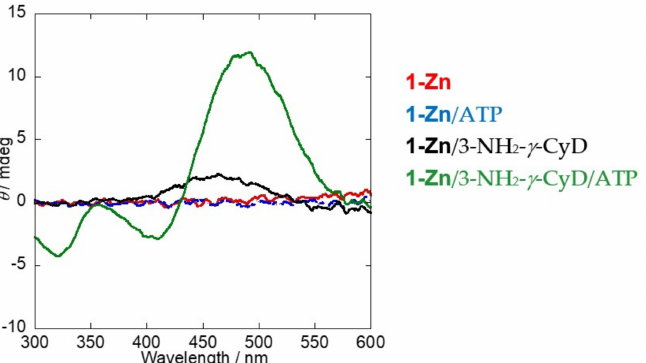
Figure 5. ICD spectra of 1-Zn , 1-Zn /ATP, 1-Zn /3-NH 2 - γ -CyD, and 1-Zn /3-NH 2 - γ -CyD /ATP. [ 1-Zn ] = 0.040 mM, [ATP] = 4.0 mM, [3-NH 2 - γ -CyD] = 4.0 mM, [HEPES] = 5.0 mM, in 2% DMSO aq. at pH 7.4.